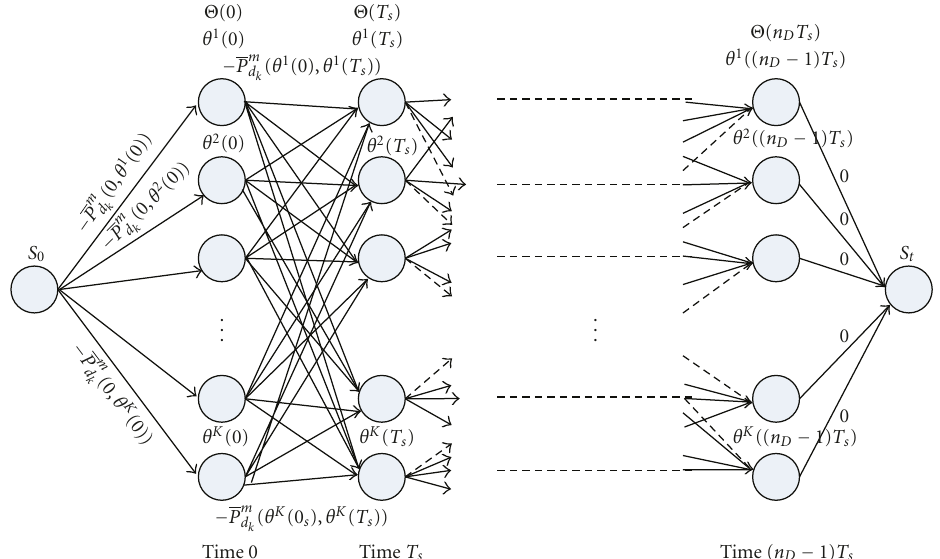
Figure 4: Shortest path representation for finding maximum detection probability at time n D T s at k th mobile node.